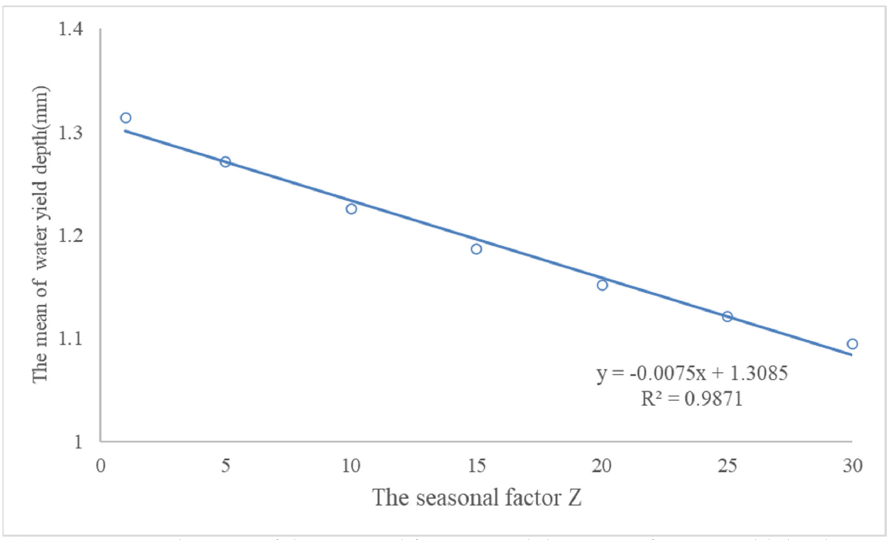
Figure 2. Scatter diagram of the seasonal factor Z and the mean of water yield depth over five